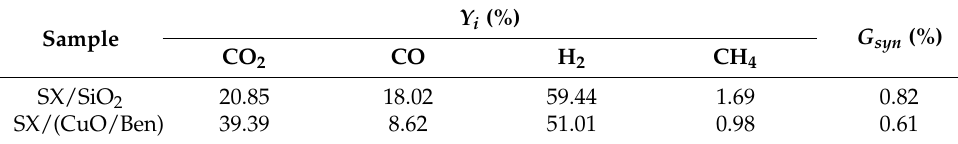
Table 3. The content of outlet gas and syngas yields of coal gasification and CLG.